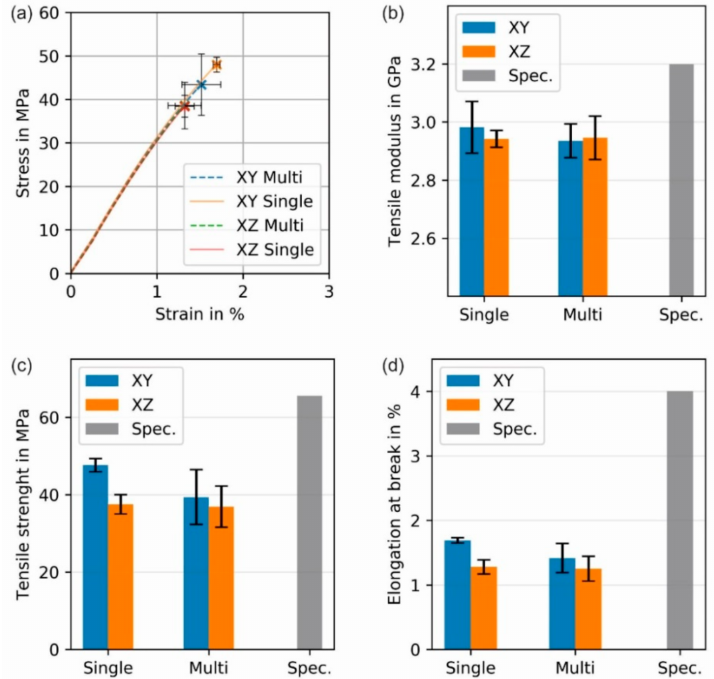
Figure 10. Tensile mechanical properties of printed specimens in two orientations (XY and XZ) and the batch of one specimen (Single) or five specimens (Multi): ( a ) stress-strain curves, ( b ) tensile modulus, ( c ) tensile strength, and ( d ) elongation at break. Specifications (Spec.) for the neat (most likely injection molded PMMA) given by the producer are given for comparison. Individual stress-strain curves can be seen in the Supplementary Information (Figure S1).